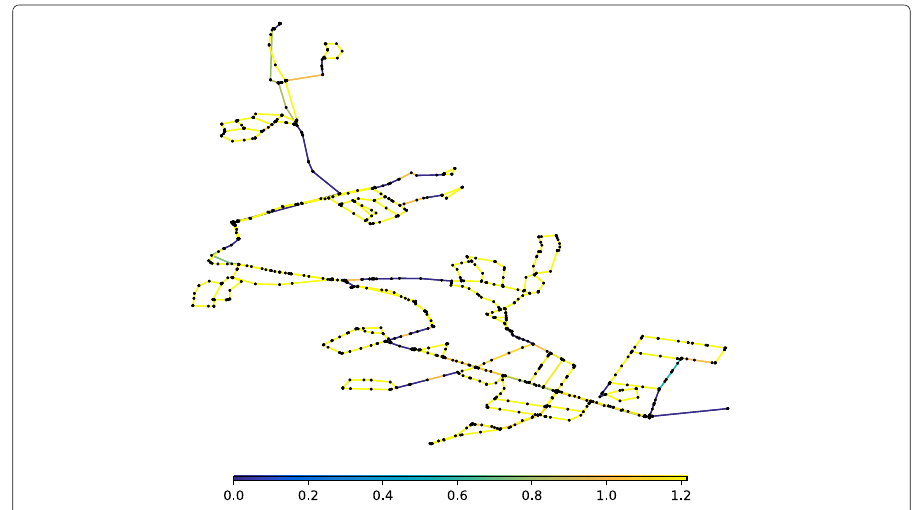
Fig. 9 Reserve capacity of BWFL core links. Only the reserve capacity of BWFL core links is computed. The hydraulic model based analysis still requires to be run on the full model, to account for head losses in